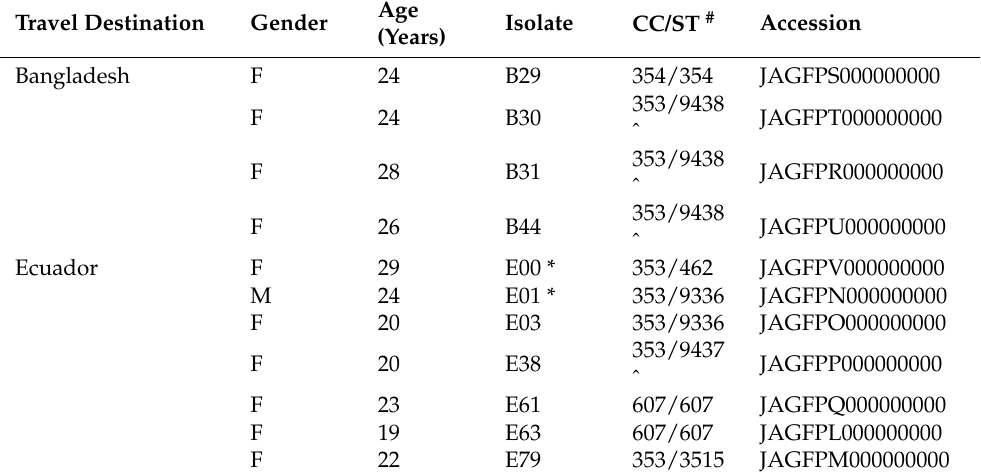
Table 1. Campylobacter –positive individuals and their C. jejuni isolates ( n = 11).